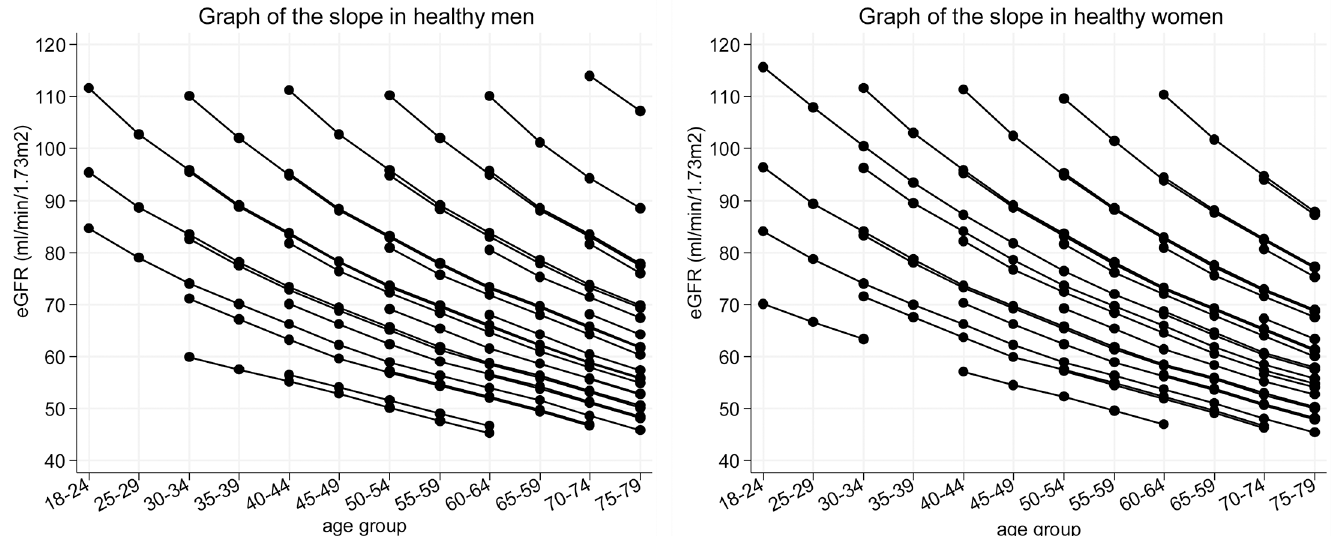
Fig 4. Graph of the slope of eGFR decline (simulated change of eGFR) in healthy men and women. The slope of eGFR decline is depicted as the inclination of each line. The trajectory of renal function based on this slope was predicted with a simulation method. The shape of the graph was gently convex downward, which matches the tendency for the slope of eGFR decline to be steeper for higher baseline eGFR and shallower for lower baseline eGFR.